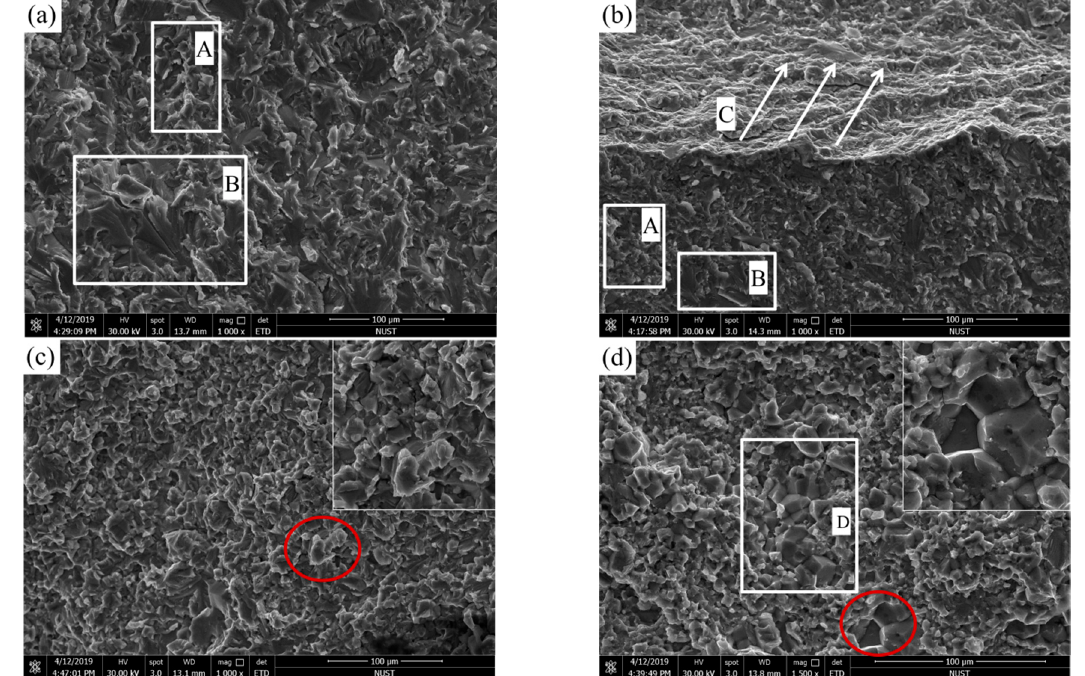
Figure 11. Fracture surface morphology of Ti-48Al-2Cr-8Nb alloy at sintering temperature of 1250 °C. ( a ) Alloy sintered by the SP powder under room temperature, ( b ) alloy sintered by the MP powder under room temperature, ( c ) alloy sintered by the SP powder under 600 °C, and ( d ) alloy sintered by the MP powder under 600 °C.